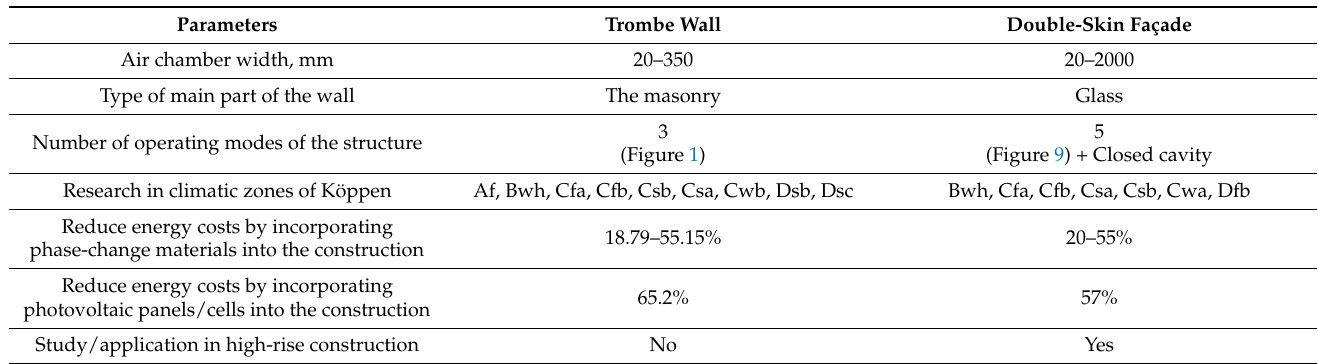
Table 2. Comparison of Trombe wall and the double-skin